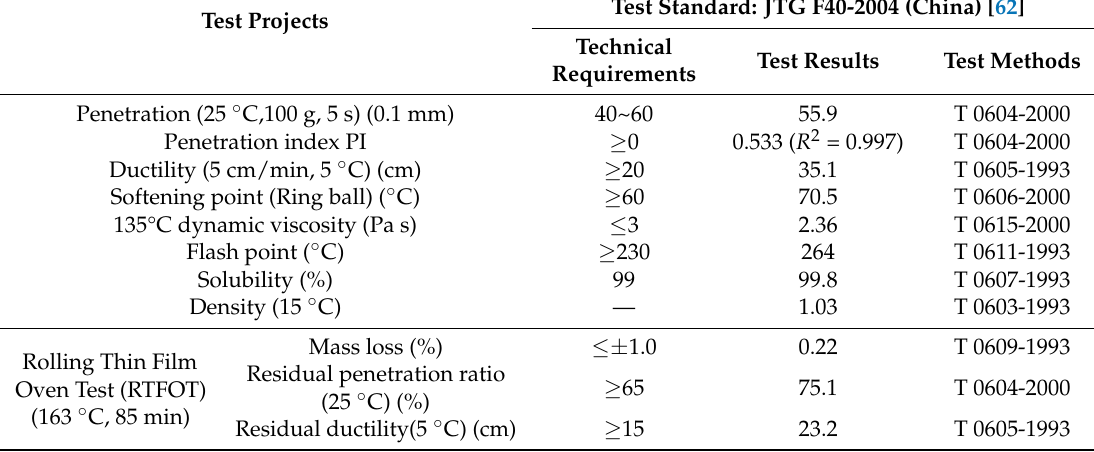
Table 1. Test results of SBS (I-D) modified asphalt.